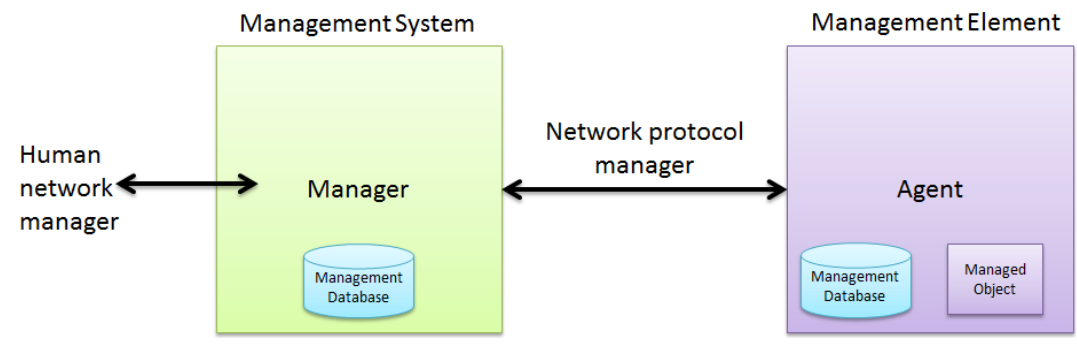
Figure 1. SNMP-based Management